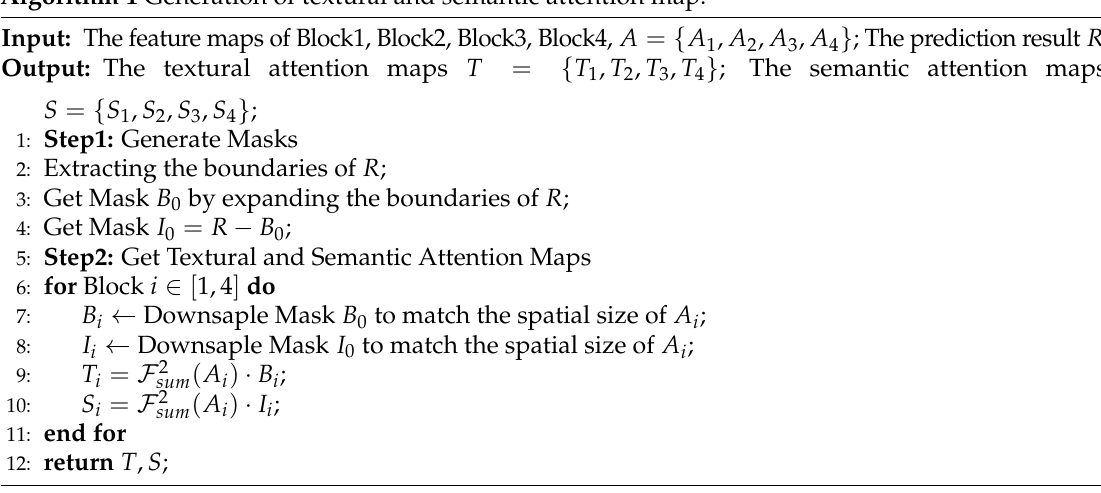
Algorithm 1 Generation of textural and semantic attention